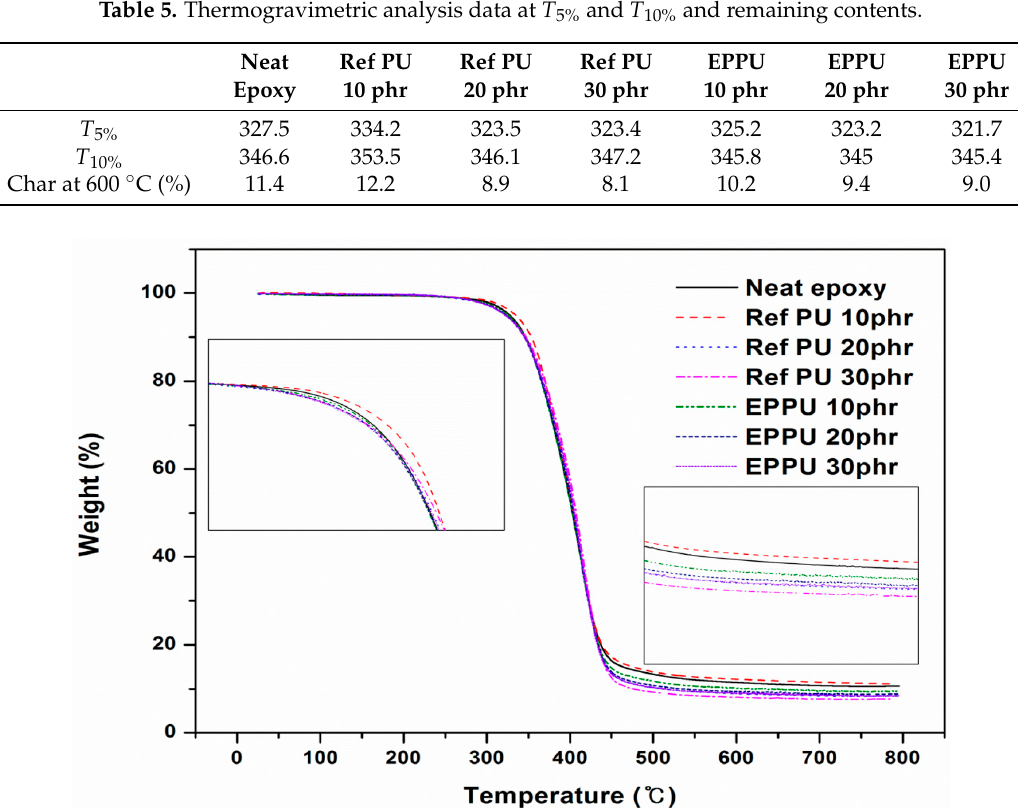
Figure 10. TGA curves for epoxy compositions including PUs.